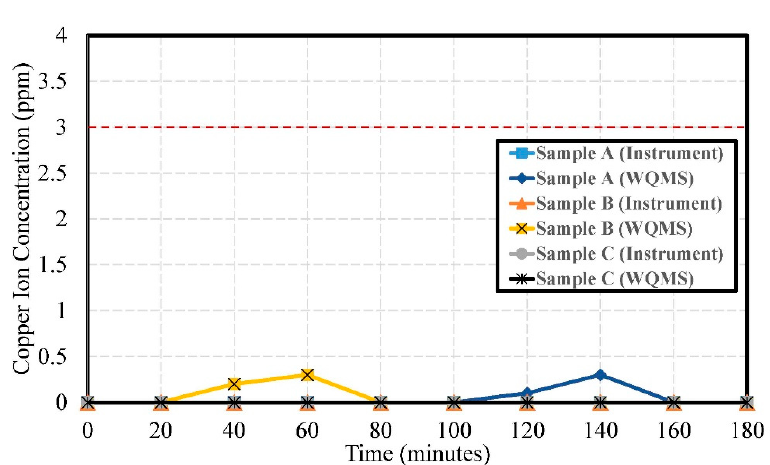
Figure 15. The experimental results of copper ion concentration by using Samples A, B, and